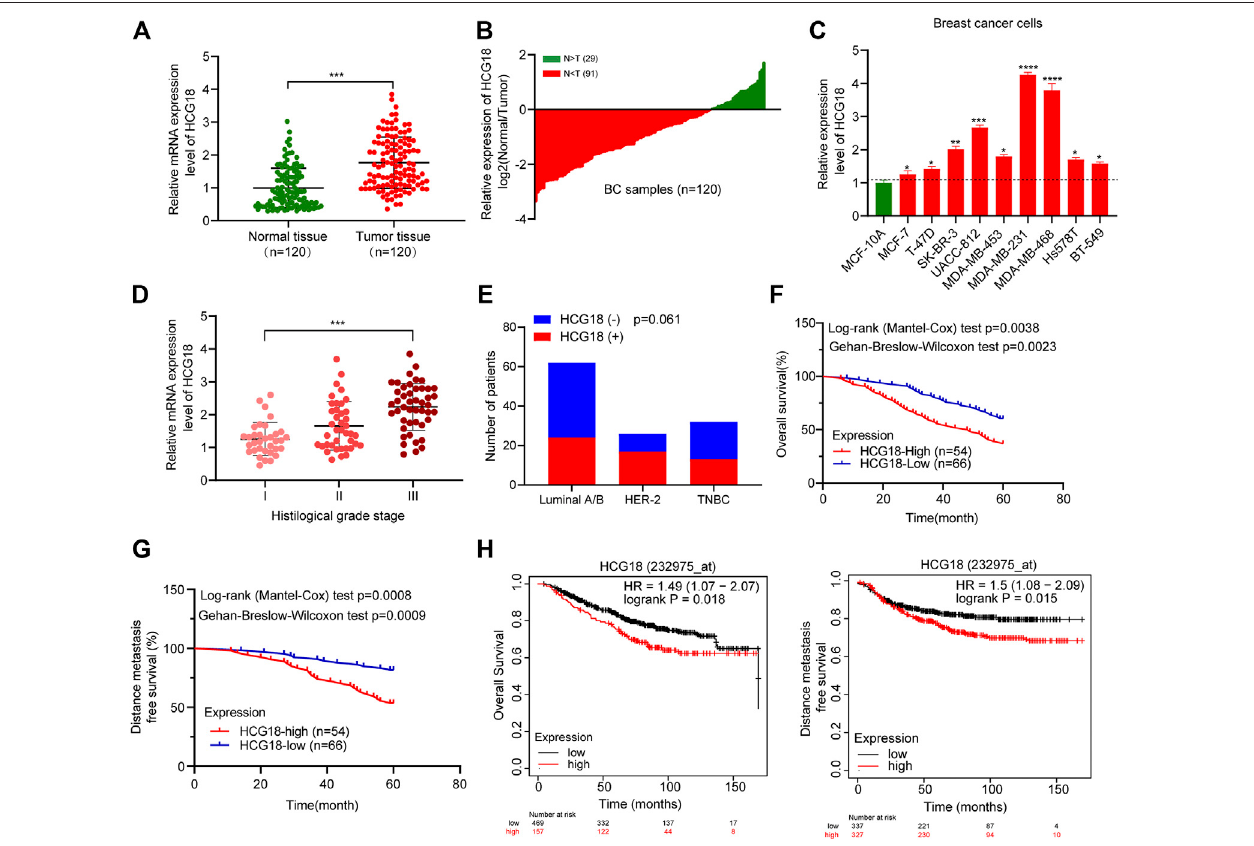
FIGURE 1 | (A , B) qRT-PCR was used to detect the expression pro fi le of HCG18 in BC tissues and normal mammary tissues. (C) HCG18 was detected by qRT- PCR in a panel of BC cell lines and a normal breast epithelial cell line (MCF-10A). (D) qRT-PCR was applied to measure HCG18 expression in BC patients with different histological grades. (E) The χ 2 test was applied to analyze the relationship between HCG18 expression and different subtypes of BC (triple-negative breast cancer [TNBC]). (F,G) Kaplan – Meier analysis showed that BC patients with high HCG18 expression had worse DMFS or OS than those with low HCG18 expression (the meanvaluewasusedtodistinguishhighorlowHCG18expressionstatus). (H) SurvivalinformationofBCpatientswithhighorlowHCG18expressionwasobtainedfrom the Kaplan – Meier Plotter database. * p < 0.05, ** p < 0.01, *** p < 0.001. The data represent at least three independent experiments.